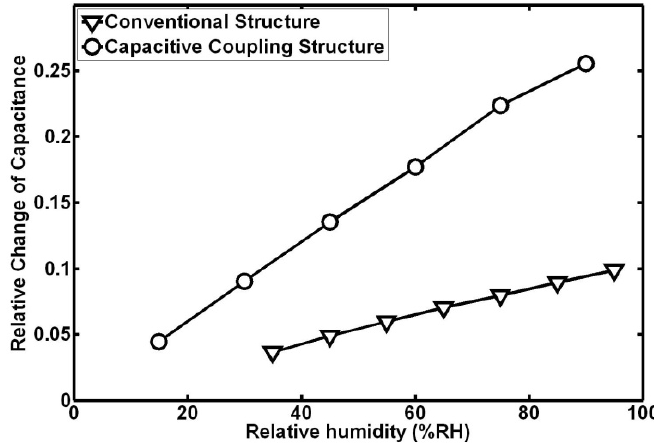
Figure 9. Relationship between relative change of capacitance and relative humidity at 25 °C.